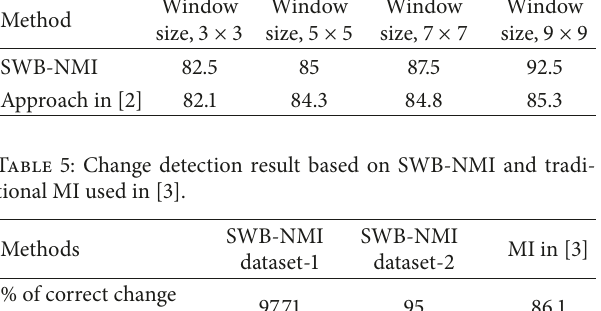
Table 4: Performance comparison in percentage between SWB- NMIandapproachin[2]withdifferentwindowsizesfor2nddataset. Method